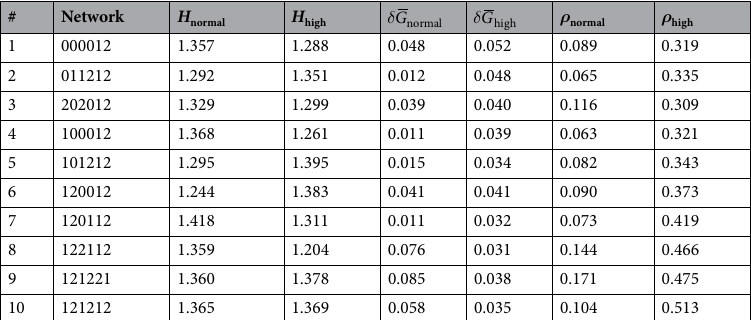
11xxxx networks show small glucose fluctuations and low inter-islet synchronization, while 22xxxx networks show large glucose fluctuations and high inter-islet synchronization. Mutual activation networks exhibit frustra- tion for the coordination between α and β cells: (internal) mutual positive interactions lead them to display in-phase coordination, while (external) glucose leads them to present out-of-phase coordination. The frustration hinders different islets from generating coherent behavior under glucose entrainment. On the contrary, mutual inhibition networks do not experience frustration, and every islet is easily entrained to external glucose with out-of-phase coordination between α and β cells. This strong correlation between glucose fluctuations and inter-islet synchronization is not always found in networks 12xxxx and 21xxxx. At normal glucose concentrations, these networks show small glucose fluctuations and low inter-islet synchronization. However, at high glucose levels, the asymmetric networks show a wide range of glucose fluctuations and inter-islet synchronization. Some networks, including the native islet network 121212, exhibit small glucose fluctuations with high inter-islet synchronization, which seems counterintuitive because the large variations in coherent hormone pulses from synchronized islets can lead to large fluctuations of glucose concentrations governed by Eq. (3). Furthermore, the out-of-phase coordination between H α and H β at high glucose levels can amplify glucose fluctuations by alternatively increasing and decreasing glucose concentrations. The network 121212 generates synchronous hormone pulses of H n α and H n β , and has the out-of-phase coordina- tion between their average glucagon H α and insulin H β . Nevertheless, it does not induce large glucose fluctuations because the combined phase of the glucose and insulin action ( G · H β ) is not out of phase with H α . The combined phase, not the pure insulin phase, regulates  G in Eq. (3). The effective phase coordination between glucose and insulin allows  G to remain negligibly small in stationary states. Thus, network 121212 can achieve coherent hor- mone pulses of synchronized islets but maintain small glucose fluctuations at high glucose levels. Effective homeostatic networks should tightly regulate the glucose concentration with small fluctuations by consuming minimal amounts of hormones. Among a total of 729 possible networks, we sorted out the effective networks that consume smaller amounts of hormones than network 000000 (no interaction between islet cells) and show small glucose fluctuations ( δ G / G < 0.1) (Fig. 2D). The applied criteria identified ten effective networks (Fig. 2E and Table 1). Indeed, these networks are subsets or transformations of network 121212 or 122112. In other words, if one removes some links or changes cell names from 121212 or 122112, the remaining eight net- works can be obtained. We noted that the asymmetric interactions between islet cells are prevalent in the ten effective networks, and mutual activation/inhibition never occurs between any pair of cells. In particular, the asymmetric interaction between β and δ cells are well conserved: nine effective networks have the xxxx12 type in which β cells activate δ cells while δ cells suppress β cells. The ten effective networks could stably regulate glucose with minimal consumption of two antagonistic hormones, insulin and glucagon. Their somatostatin consump- tion was also relatively minimal (Table S2). Moreover, they showed controllable inter-islet synchronization with low/high synchronization index at normal/high glucose (Table 1). Among them, the fully connected networks 121212, 121221, and 122112 showed higher inter-islet synchronization at high glucose. Here, network 121221 is topologically equivalent to network 121212. The name switch between β and δ cells can transform network 121221 to network 121212. On the other hand, networks 121212 and 122112 are topologically distinct. Network 121212 exhibits distinguishable cells: one cell suppresses the other two; one cell enhances the other two; and one cell suppresses one and enhances one. However, network 122112 shows indistinguishable cells: every cell sup- presses and enhances the others. In other words, if one hides cell names, one cannot distinguish between cells. Here, network 122112 may require more complex sets of receptors to realize the interaction topology because one cell must affect the other two cells differently. Finally, we have also examined the phase coordination between three hormones for the ten effective networks. Networks 121212 and 120012 clearly reproduced the out-of-phase coordination between insulin and glucagon pulses, and the in-phase coordination between insulin and somato- statin (Fig. S9), as experimentally observed by Hellman et al . 7 In summary, network 121212 outstands in many aspects such as minimal hormone consumption, stable glucose regulation, controllable inter-islet synchroniza- tion, and clear phase coordination between three hormones. The effective networks display the special feature of controllable inter-islet synchronization depending on glucose conditions. In contrast, although network 000000 (no interaction between islet cells) consumes relatively small